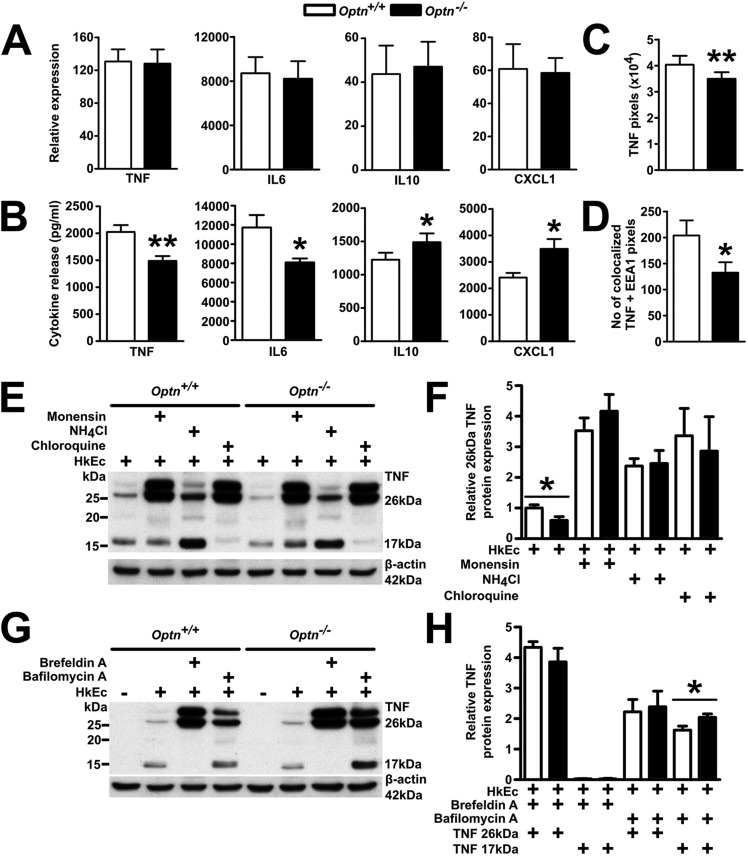
OPTN-deficient BMDMs secrete lower levels of proinflammatory cytokines on bacterial challenge. (A) Tnf, Il6, Il10 and Cxcl1 gene expression in Optn+/+ and Optn−/− BMDMs after stimulation with HkEc was measured with qRT-PCR (n=5 mice/group over 5 experiments). (B) TNF, IL6, IL10 and CXCL1 cytokine release in Optn+/+ and Optn−/− BMDMs after stimulation with HkEc was quantified using a multiplex cytokine plate (n=5 mice/group over 5 experiments). (C) Confocal microscopy in BMDMs stimulated with HkEc for 4 h and stained for intracellular TNF were quantified using ImageJ (n=177-178 cells/genotype over 2 experiments). (D) Confocal microscopy in BMDMs stimulated with HkEc for 4 h and stained for intracellular TNF and EEA1 were quantified using ImageJ (n=62-66 cells/genotype over 2 experiments). (E) Representative TNF immunoblot of whole cell lysates from BMDMs exposed to HkEc in the presence of lysosomal inhibitors. (F) Quantification of immunoblots for TNF showed significantly less intracellular 26-kDa precursor TNF in the BMDMs from Optn−/− mice, which is normalised to wild-type levels on addition of lysosomal inhibitors monensin, NH4Cl or chloroquine (n=3-8 mice/genotype over 3-5 experiments). (G) Representative TNF immunoblot of whole cell lysates from naïve and HkEc-stimulated BMDMs in the presence of brefeldin A or bafilomycin A. (H) Quantification of immunoblots for TNF in the presence of brefeldin A shows undetectable levels of the 17-kDa secreted form of TNF, whereas bafilomycin A results in significantly higher levels of the 17-kDa secreted TNF in Optn−/− BMDMs (n=3-8 mice/genotype over 3-5 experiments). Results shown are mean±s.e.m., all immunoblots are normalised to actin (*P<0.05, and **P<0.01; two-tailed, unpaired t-test).